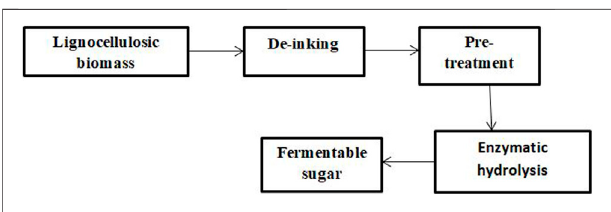
FIGURE 1 | Process involved in the production of reducing sugars via block diagram (Ojewumi et al., 2018).